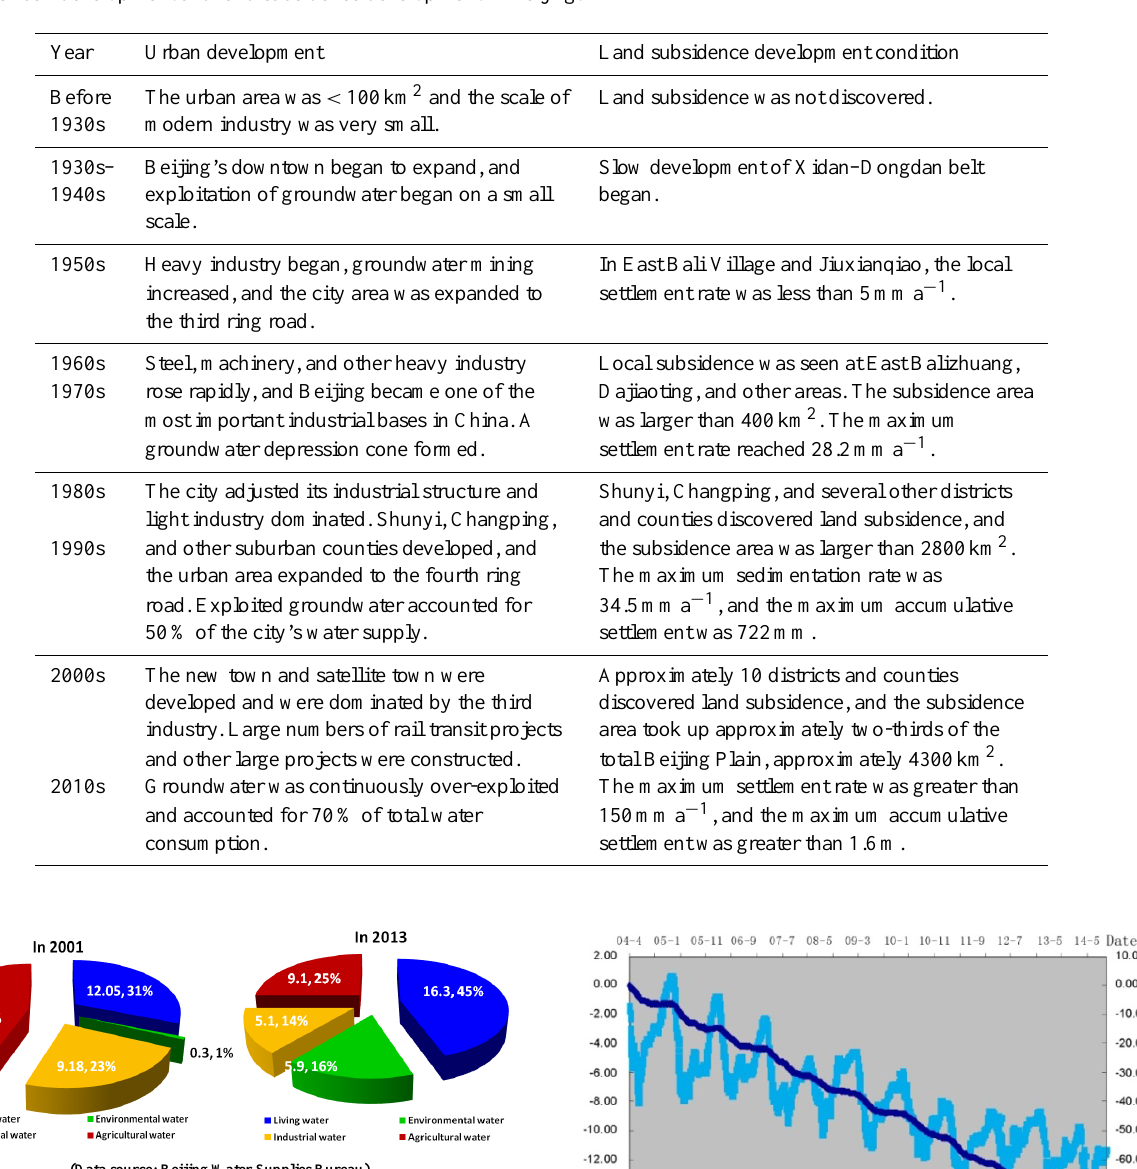
Table 1. Urban development and land subsidence development in Beijing.